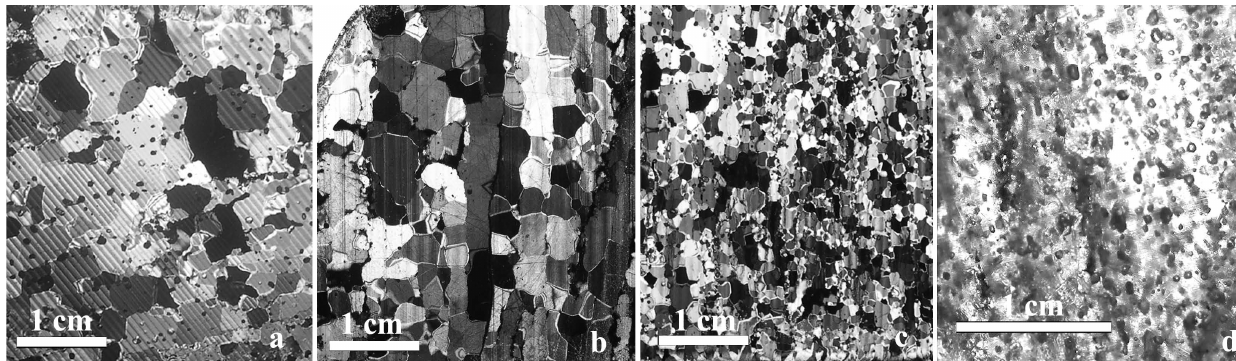
Fig. 3. Thin section photographs of ice wedge texture: (a) IW-26; (b) ISW-28 (ice-sand wedge), the left part of ice wedge 28 with debris subvertical layers (note the crystal elongation along the foliation); (c) IW-28, clean ice in the central part of ice wedge 28; and (d) thick section photograph of ice from IW-28 in transmitted light allowing bubble content